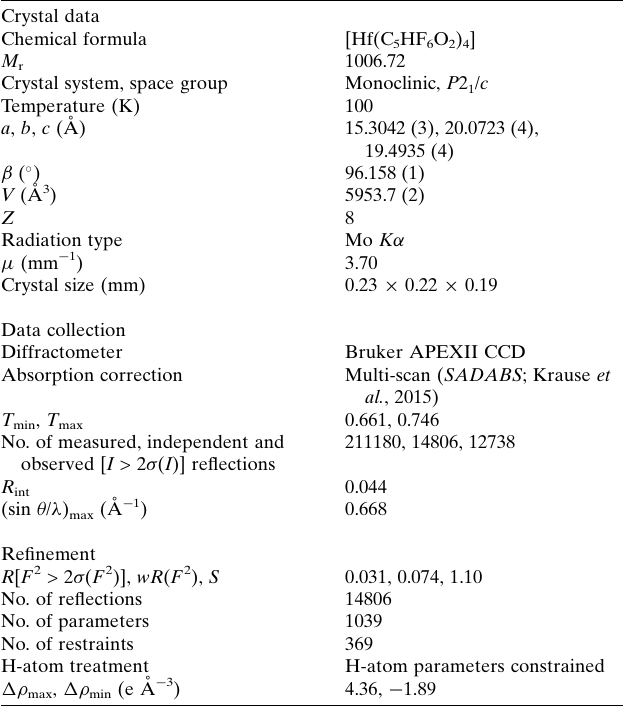
Table 2 Experimental details. Crystal data Chemical